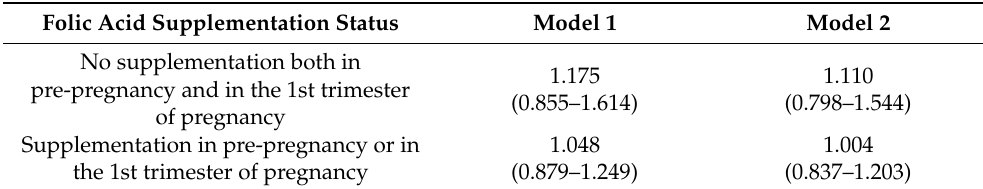
Table 5. Association of peri-conceptional folic acid supplementation status with children’s early adiposity rebound [n = 2267, OR